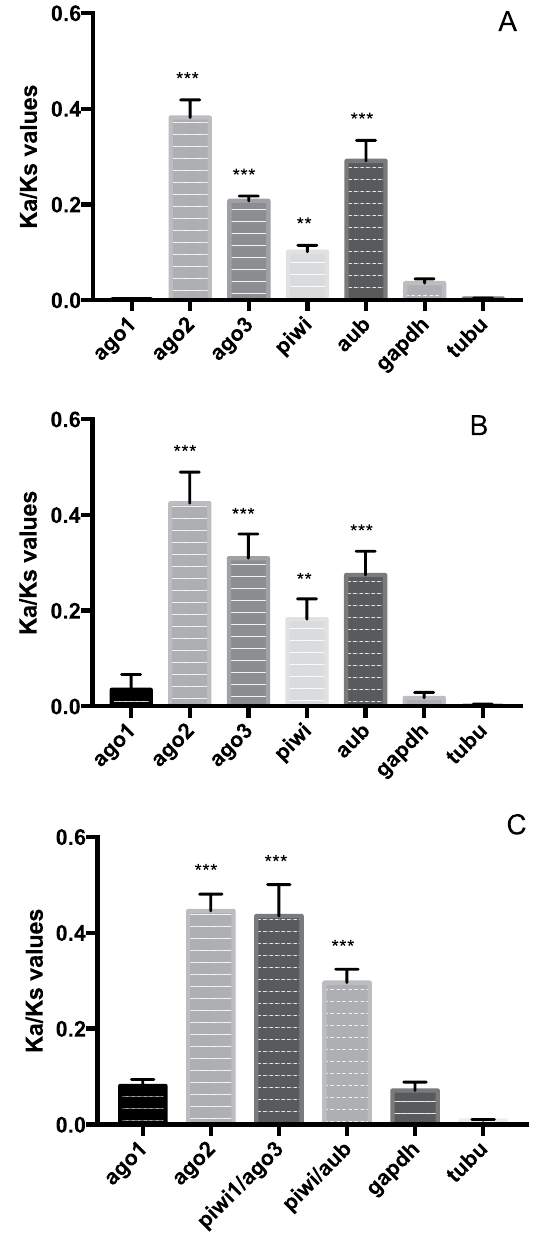
Figure 3. The evolutionary rate of argonaute sequences within the Drosophila genus, estimated by determining the Ka versus Ks substitutions by pairwise (Fig. 3A) and ML-tree based (Fig. 3B) comparison and using sequence information of D . melanogaster , D. simulans , D . sechellia , D. yakuba and D. erecta . Figure 3C: Rate of molecular evolution of argonaute sequences within the Insecta class. For this, sequence information of the D. melanogaster , Bombyx mori , Tribolium castaneum and Schistocerca gregaria argonaute coding regions was used as query. The bars represent the mean + / − SEM of individual Ka/Ks values per gene. Statistics (MWU-test) support difference with the housekeeping genes glyceraldehyde 3-phosphate dehydrogenase (gapdh) and apha- tubulin1a (tubu); ** p < 0.01, *** p <